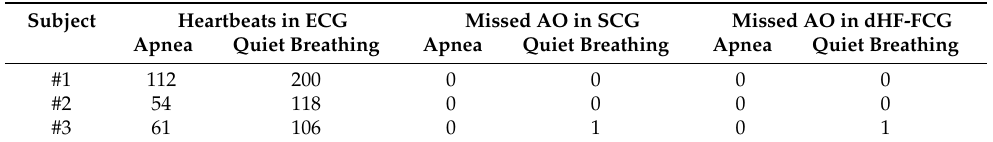
Table 2. Number of heartbeats in ECG and of missed AO events in SCG and in dHF-FCG for each subject in quiet breathing and apnea